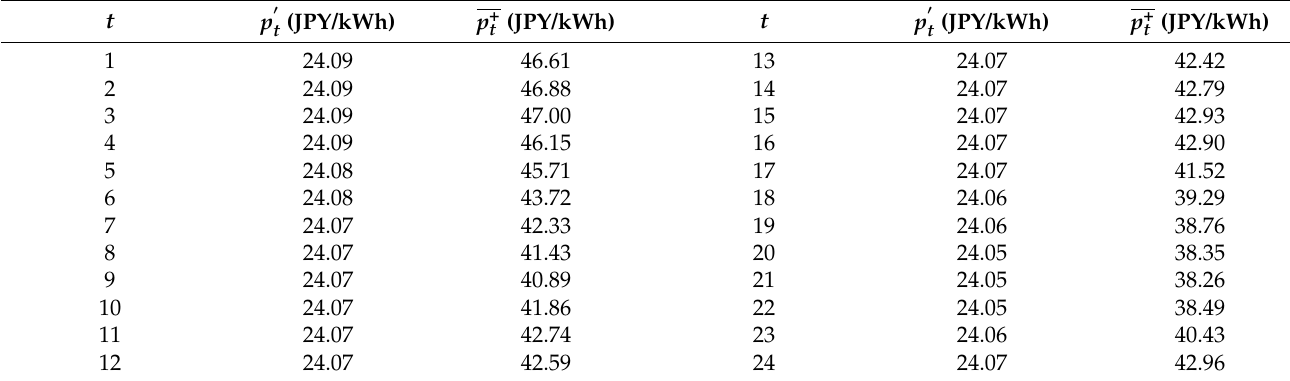
Table 4. Numerical simulation results of price-based demand response programs (DRs) under scenario 1.